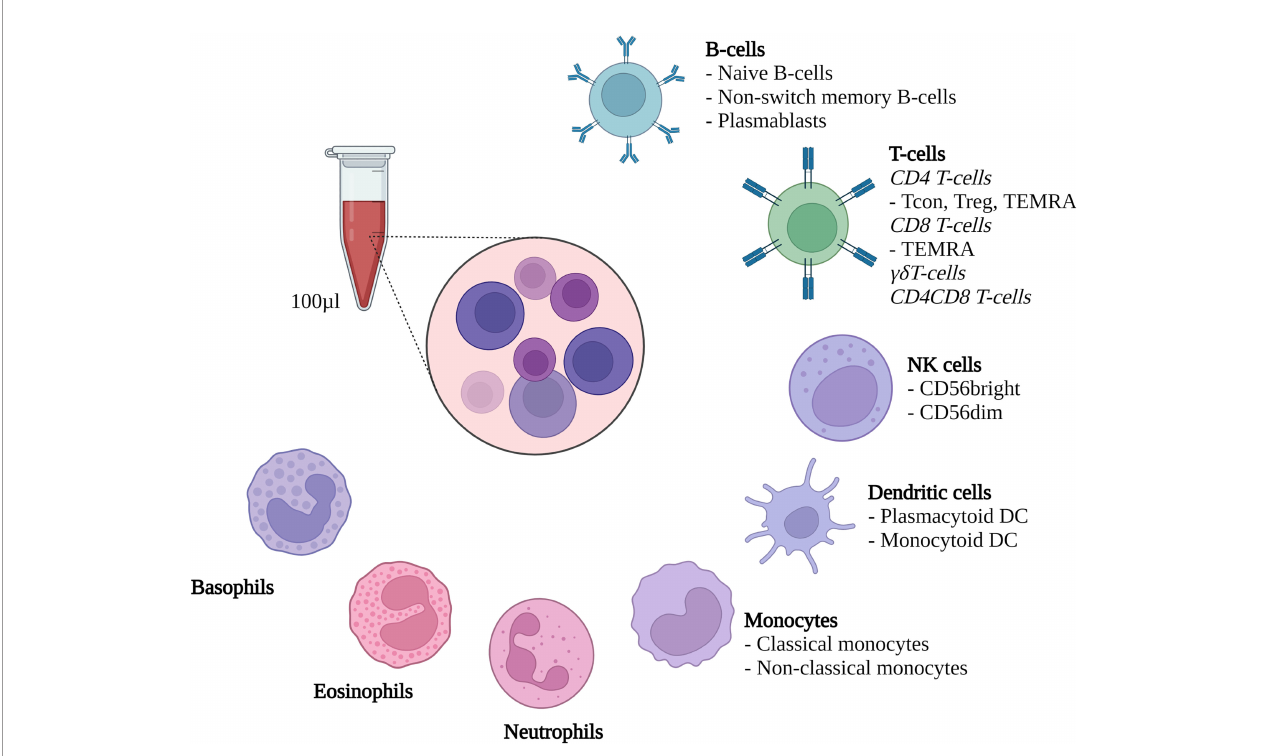
FIGURE 1 | Methodological set-up. Flow cytometric evaluation of the depicted cell types from 100µl heparinized whole blood. Treg, Regulatory CD4 T-cells; Tcon, conventional CD4 T-cells; TEMRA, Terminally differentiated effector memory T-cells; DC, Dendritic cells; NK cells, Natural killer cells. Created with